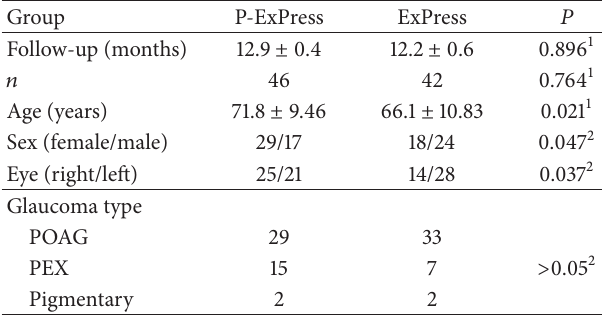
Table 1: Patient’s demographic